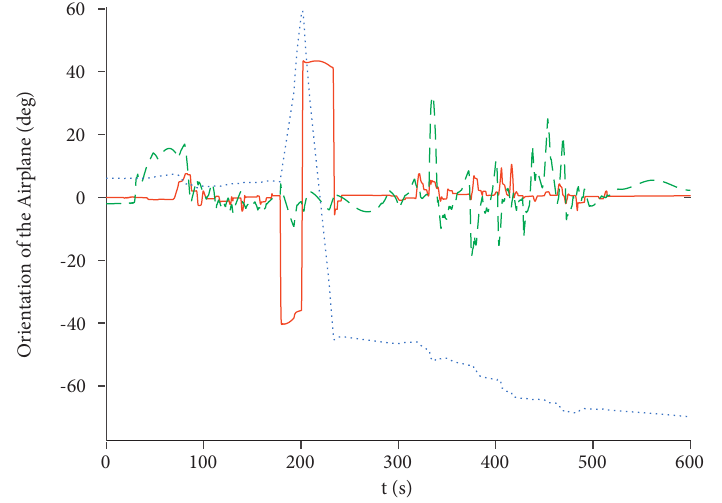
Figure 6. Overview of the flight test used in the classical washout filter